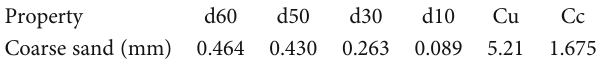
Figure 2: Diagram of interface. Table 1: Characteristic size and